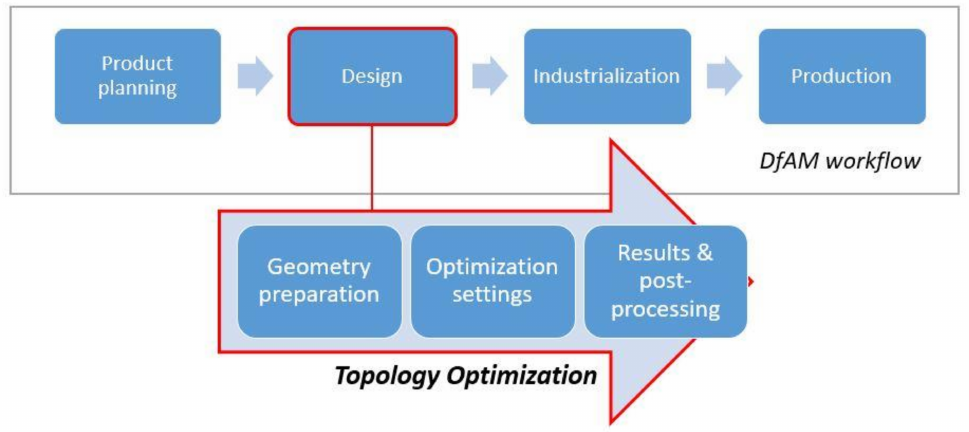
Figure 1. Topology optimization